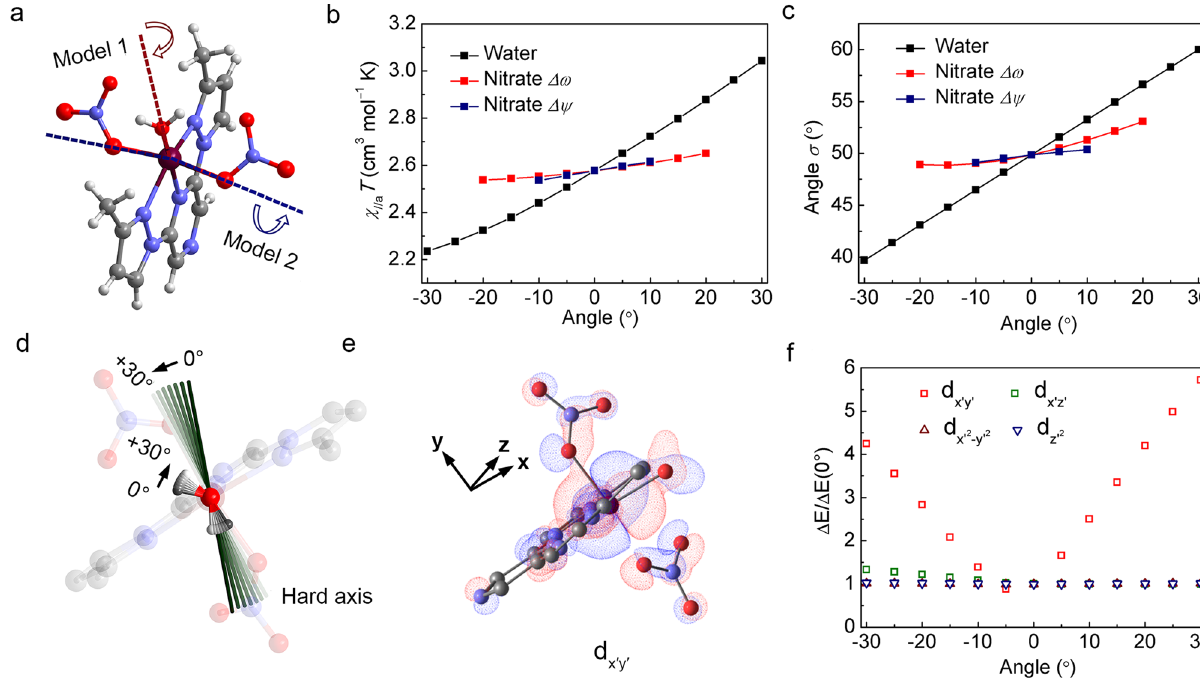
Fig. 5 Variations in the magnetic anisotropy parameters with the rotation of water and nitrates from ab initio calculations. a Two molecular models (model 1, rotation of the water molecule; model 2, rotation of nitrates) based on the structure of LTp for calculations. b Magnetic susceptibility along the a -axis. c Deviation in the angle, σ , change with the rotation angle in the two models. d Schematic diagram of the change of the direction of the magnetic hard axis with the rotation of the water molecules. e Overlap between the d orbital centered on the cobalt and the p orbitals of the oxygen from the water and the nitrates in the highest fully occupied d orbital ( d x ′ y ′ ), where the red color corresponds to the regions where the phase of the wave function is positive, and the blue color corresponds to the regions where the phase of the wave function is negative. The reference coordinate axes are de fi ned in Supplementary Fig. 14a. f Energy differences between the d orbitals and the d y ′ z ′ orbital ( Δ E ) with respect to those of the initial state [ Δ E (0°)] change with the rotation of water. Maroon, Co; gray, C; blue, N; red, O; light gray,